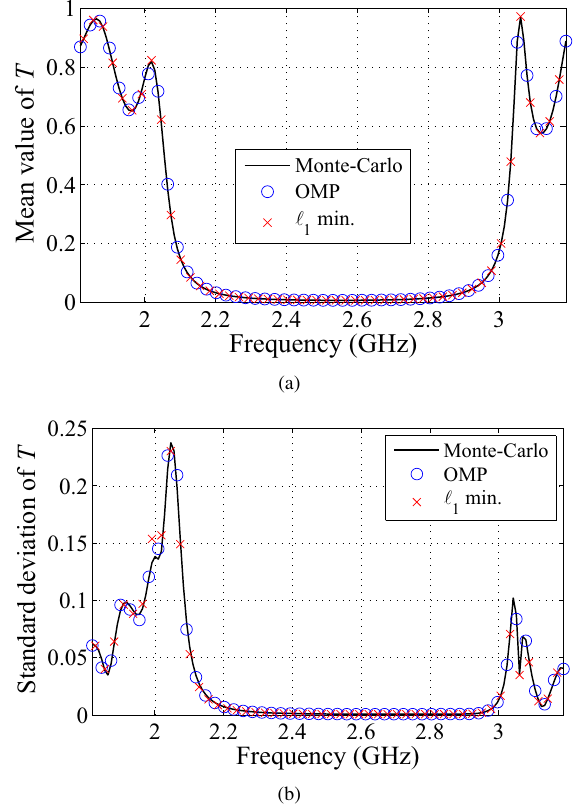
Figure 6: (a) Mean value and (b) standard deviation of the transmission coefficient T of the dielectric-stack filter of Fig. 5 for normal